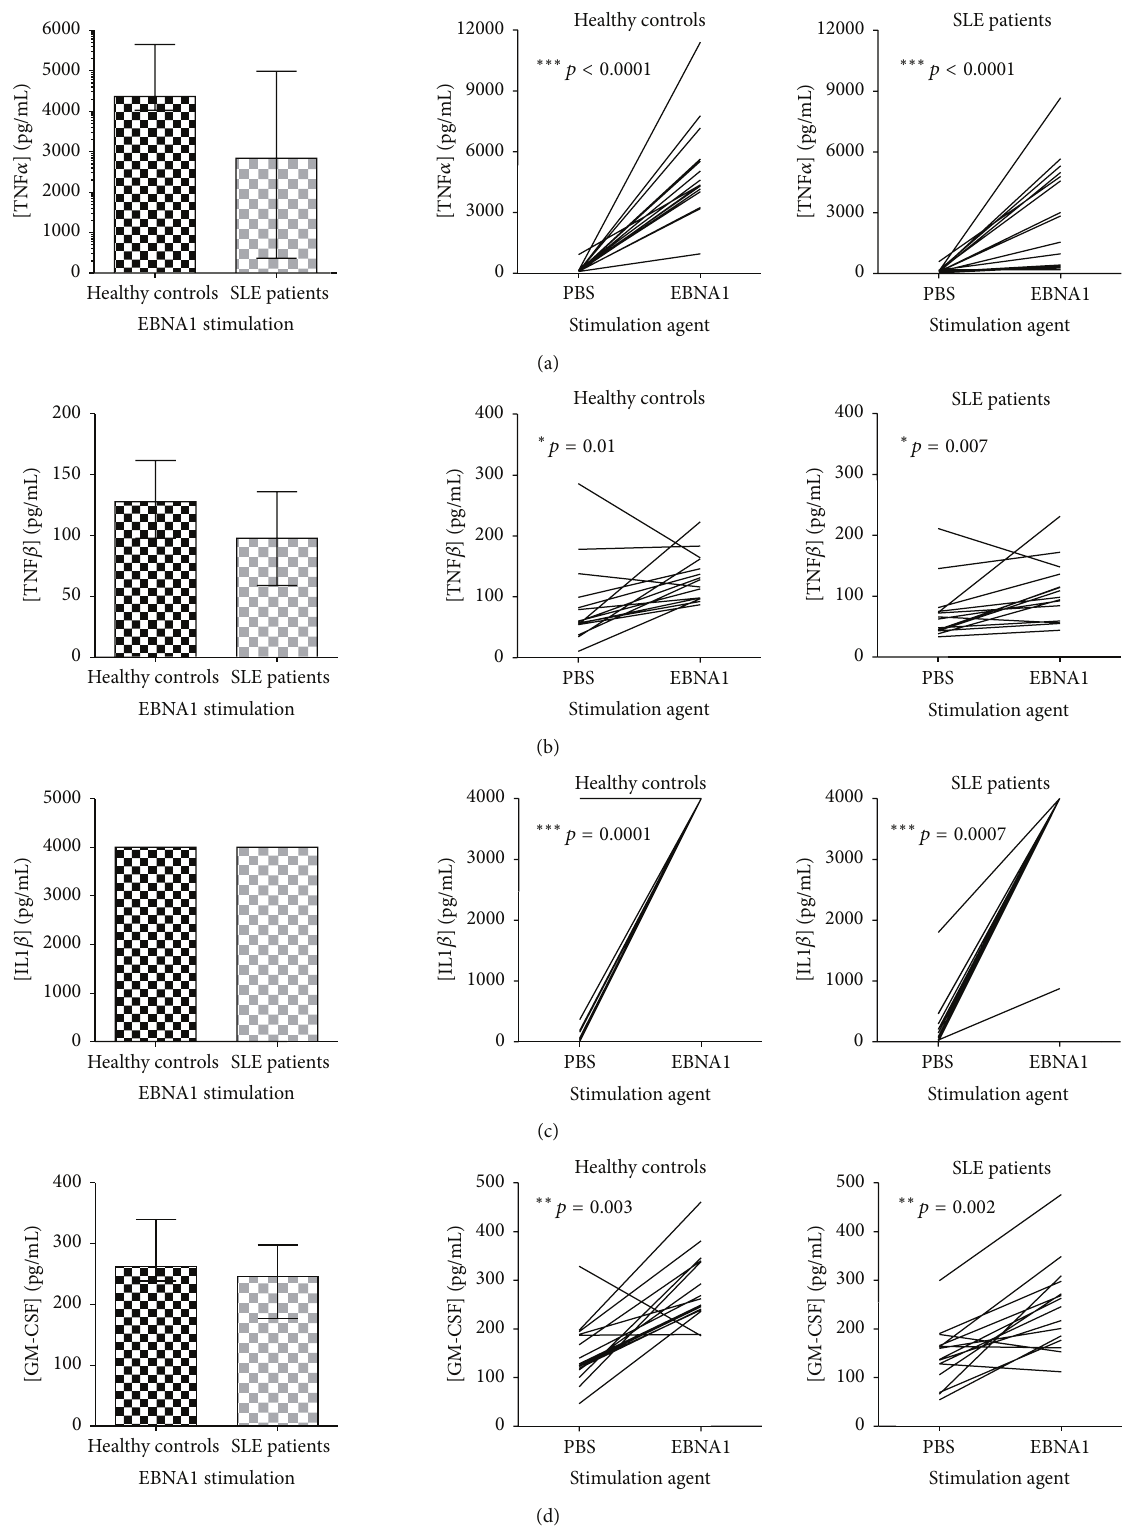
Figure 2: Inflammatory cytokines, TNF 𝛼 (a), TNF 𝛽 (b), IL1 𝛽 (c), and GM-CSF (d), with similar induction in SLE patients and in HCs upon EBNA1 stimulation. TNF 𝛼 (a), TNF 𝛽 (b), IL1 𝛽 (c), and GM-CSF (d) quantified in dried blood spot samples from SLE patients (with normal lymphocyte levels, 𝑛 = 15 ) and sex- and age-matched HCs ( 𝑛 = 15 ) by multiplexed Luminex assay with addition of HBR+. Left: cytokine concentrations (pg/mL) in SLE patients and HCs upon EBNA1 stimulation. Data are presented as median with interquartile range. 𝑝 values for comparison of SLE patients and HCs are 0.083, 0.103, 0.310, and 0.050 in (a), (b), (c), and (d), respectively. Right: induction of cytokines (pg/mL) from basic levels (PBS stimulation) by EBNA1 stimulation in SLE patients and